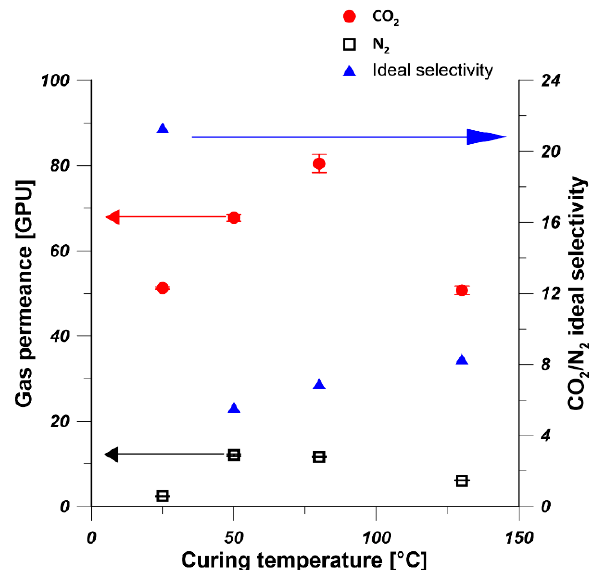
Figure 7. Effect of curing temperature on gas permeance and ideal selectivity of PDMS/PEI mem- branes (PDMS concentration—15 wt% and coating time—10 min).